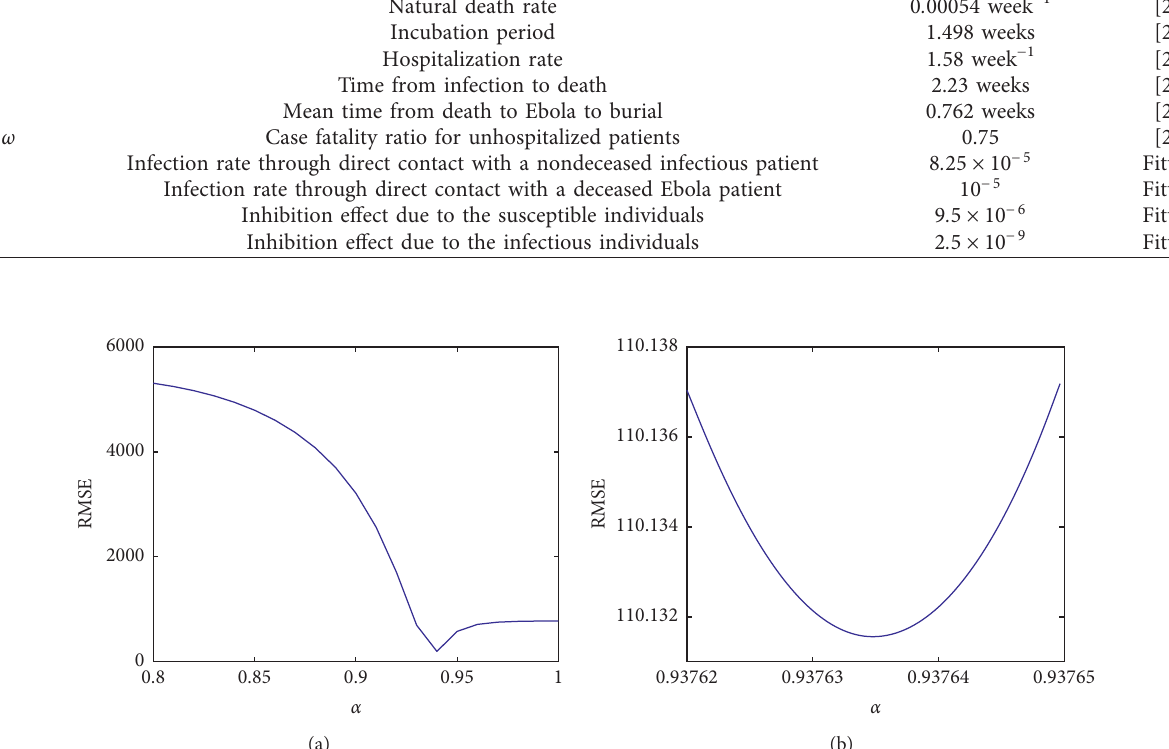
Figure 2: The root-mean-square error (RMSE) for different derivative orders. In (a) a more wider range of α is considered and in (b) we refined the range of α so as to improve precision on determining the minimum error of estimation and we observed that it occurs when α � 0 . 937635.